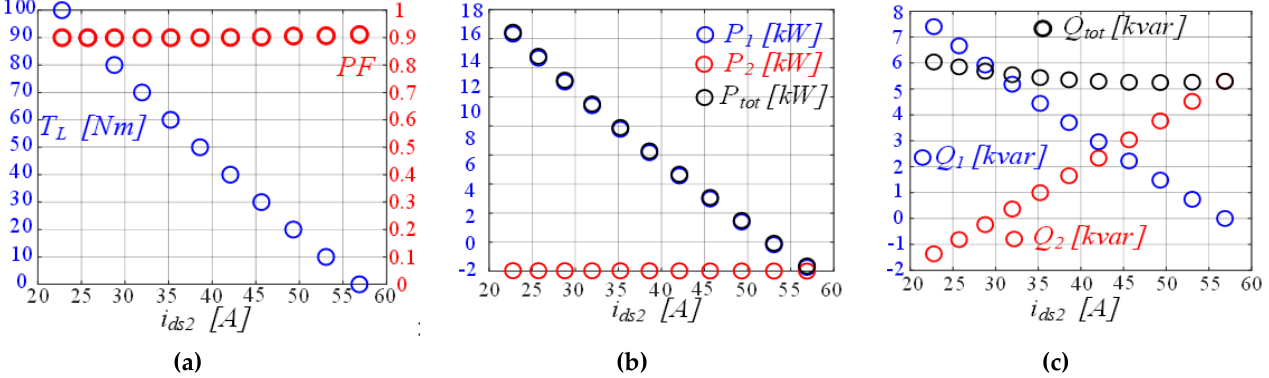
Figure 11. ( a ) Power factor control: T L and PF vs. i ds2 ; ( b ) P 1 , P 2 , P tot = P 1 + P 2 ; ( c ) Q 1 , Q 2 and Q tot = Q 1 + Q 2 .